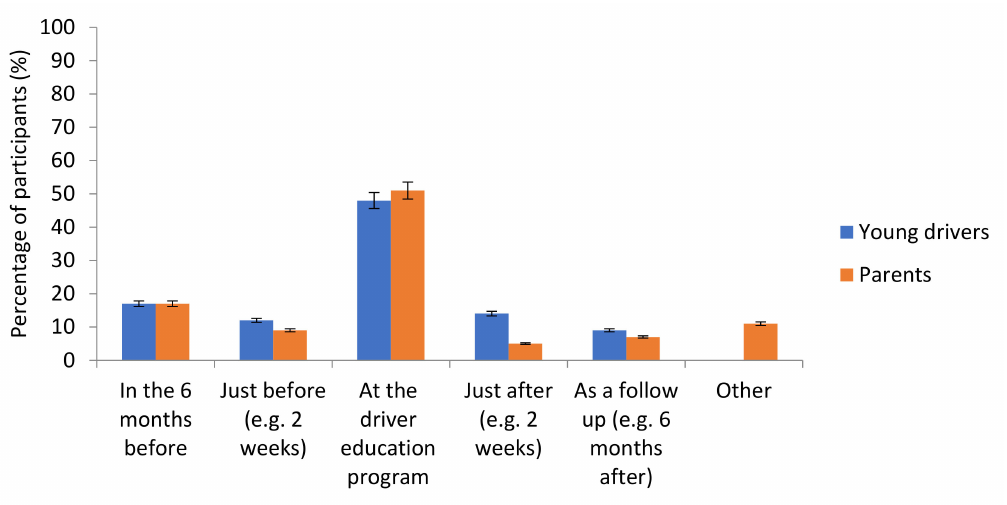
Figure 4. Percentage of young driver and parent responses indicating the optimal timing for training using a driving simulator.